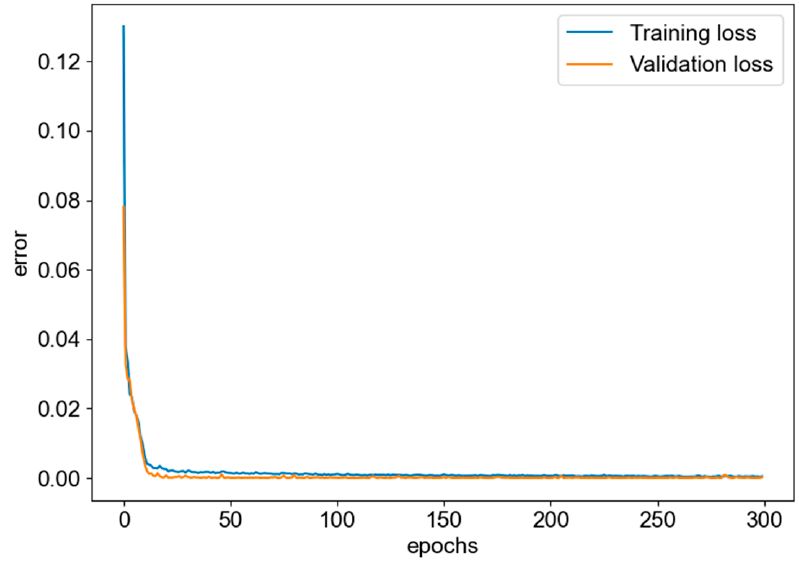
Figure 2. AQ1033 error curve.